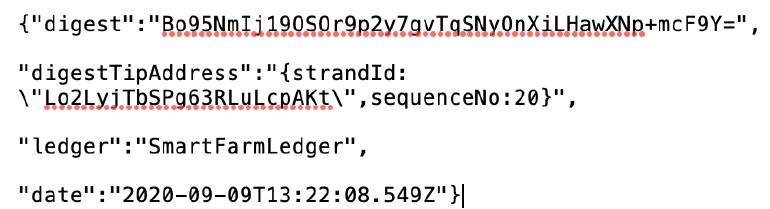
Figure 8. The output of “TokenBalance” table history.